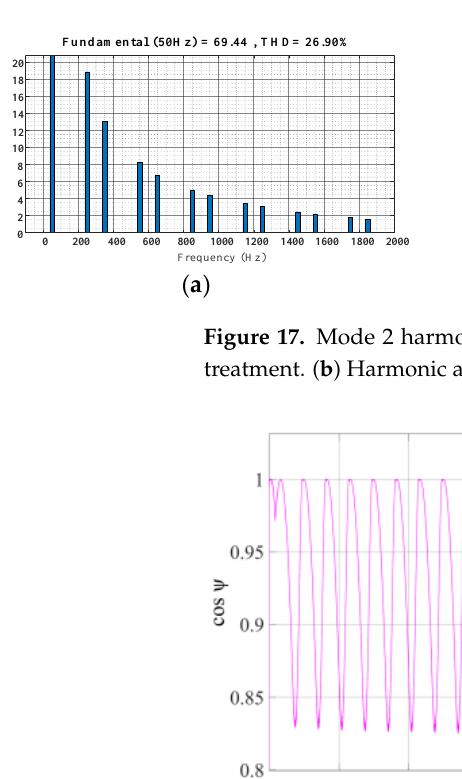
Table 3. The Experimental parameters.